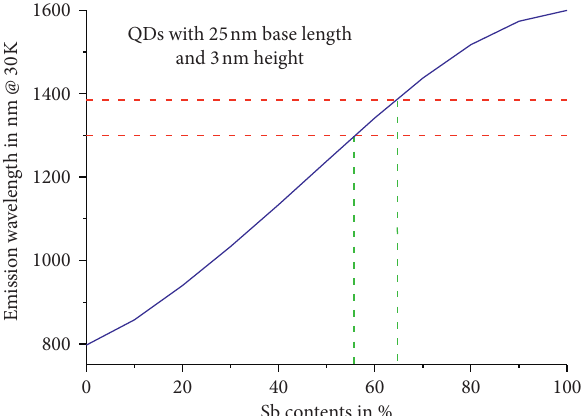
Figure 5: Simulated emission wavelength for different uncoupled QD sizes and Sb contents (1 − y ) within the GaAs substrate. The wavelength is above 1.3 µ m for Sb contents of 55% and more.